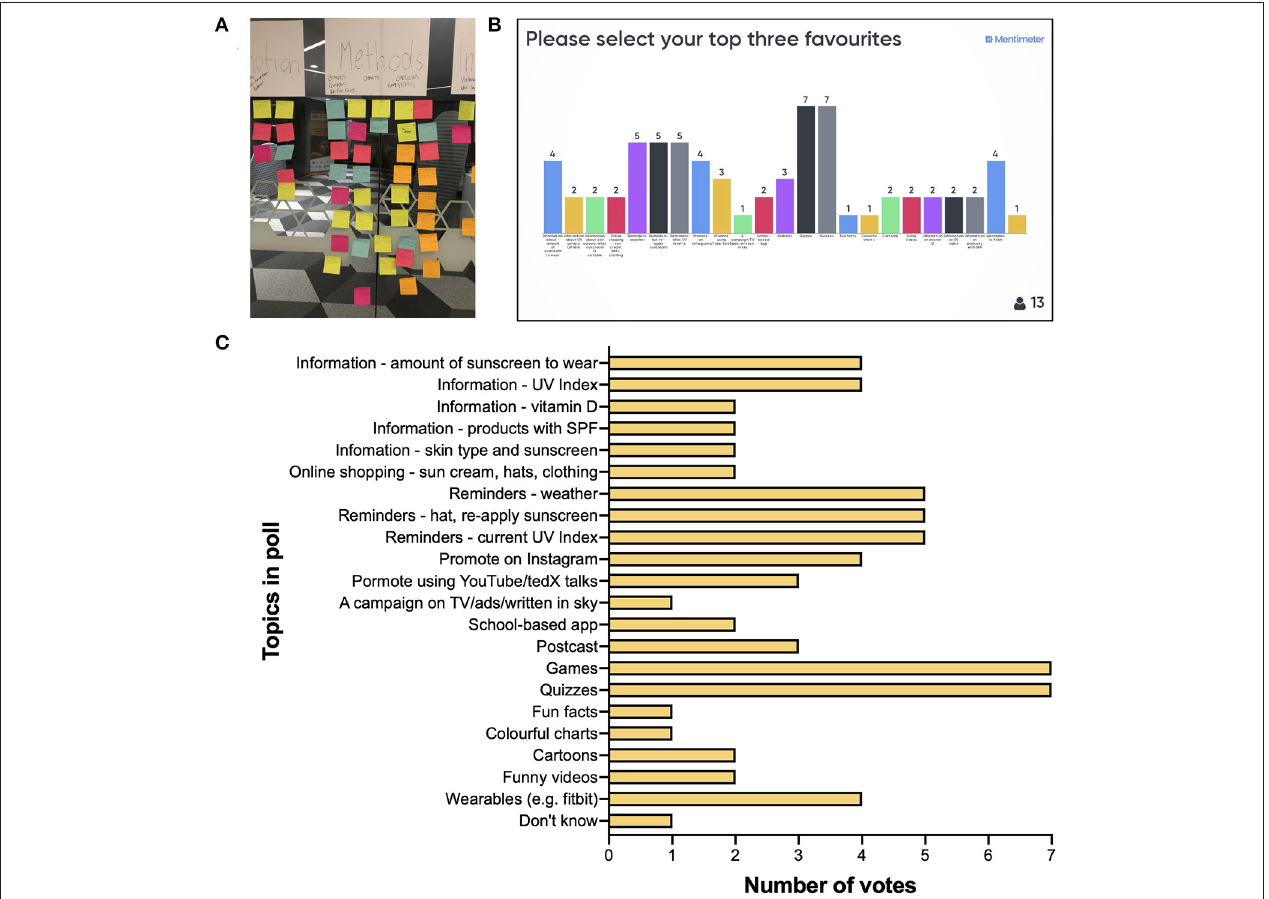
FIGURE 3 | (A) Ideas generated by co-researchers ( n = 20) attending Workshop 1 from a How-might-we brainstorming addressing the question, “How might we use technology to support sun safe practices?” that were categorized into a “Methods” theme (only 37 of 46 final ideas depicted). Co-researchers were invited to vote ( via secret ballot using the Mentimeter online tool) for their top 3 favorite ideas of 21 selected by researchers at the workshop, with a screenshot of the Mentimeter poll results shown in (B) and these results re-graphed (for clarity) in (C) for 69 votes cast in total. n.b. Only 13 of 20 co-researchers attending the workshop participated in this poll, during which problems with Wi-Fi were experienced. SPF, sun protective